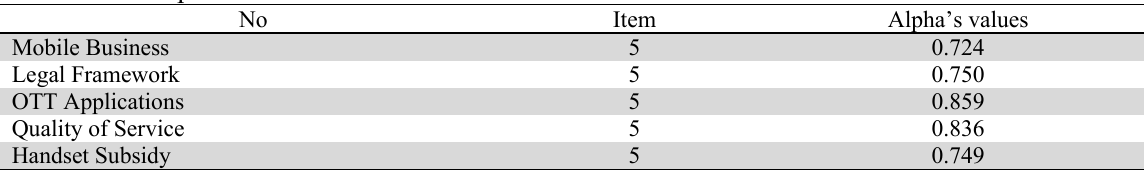
Croanbach’s Alpha Values